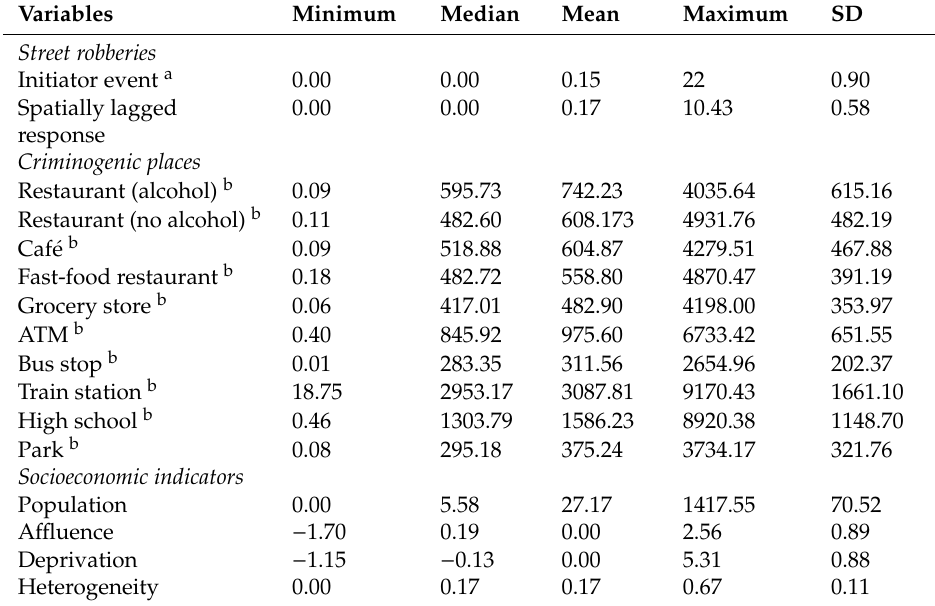
Table A1. Descriptive statistics of response and predictor